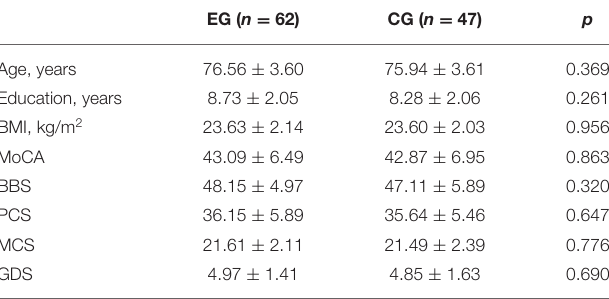
TABLE 1 | Baseline characteristics of participants.